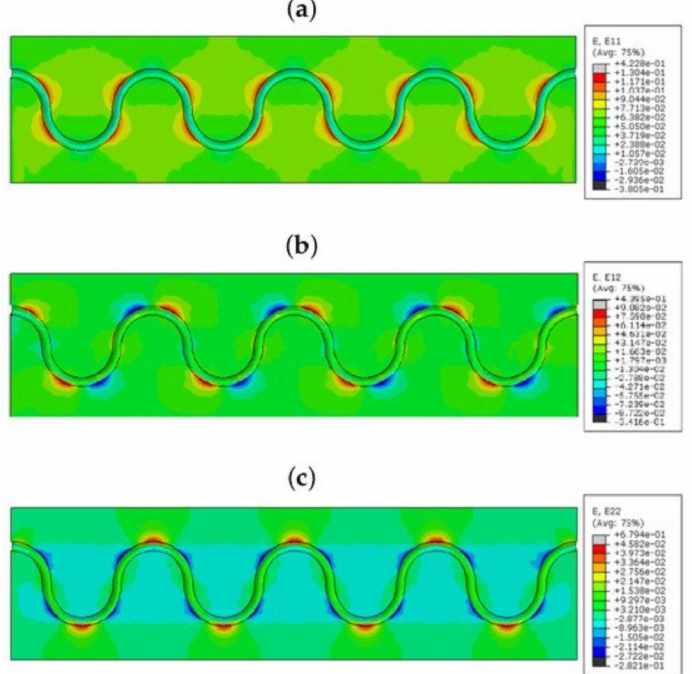
Figure 3. ( a ) E 11 strain component; ( b ) E 12 strain component; ( c ) E 22 strain component (acrylate-coated FOS numerical model; the value observed in the host epoxy), sinusoidal alignment. Multiparameter strains are clearly visible in sinusoidal placement. Straight placement shows lateral strains only while sinusoidally placed FOS shows strain in linear, shear, and lateral